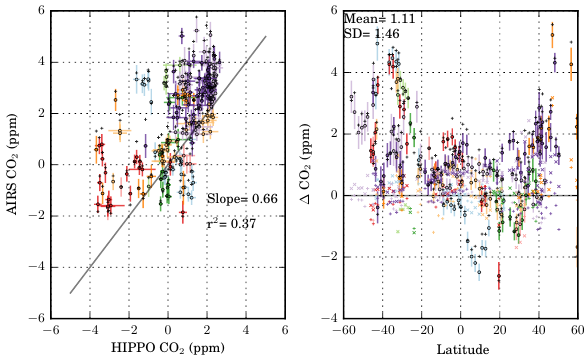
Figure 11. Left: scatter plot of normalized (with campaign aver- age) CO 2 from individual HIPPO profiles ( x axis) against corre- sponding AIRS data. Right: difference plot of CO 2 against latitude. Campaigns as well as north and southbound tracks are color coded, model–HIPPO differences are plotted as well. Please refer to Fig. 7 for a detailed